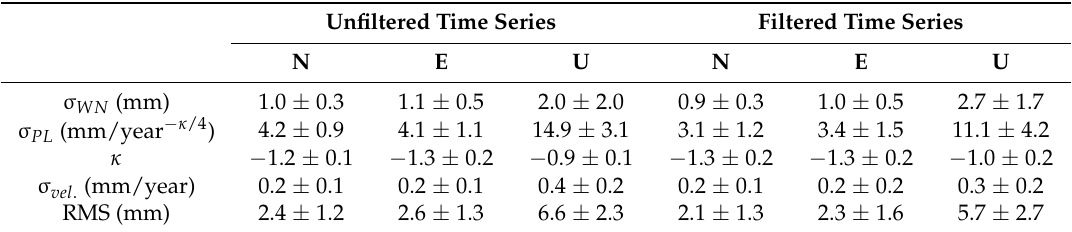
Table 1. Mean and standard deviations of the WN amplitude ( σ WN ), PLN amplitude ( σ PL ), spectral index, and velocity uncertainty ( σ vel . ) and the RMS of the unfiltered and filtered CMONOC-I time series estimated with the PLN + WN model.